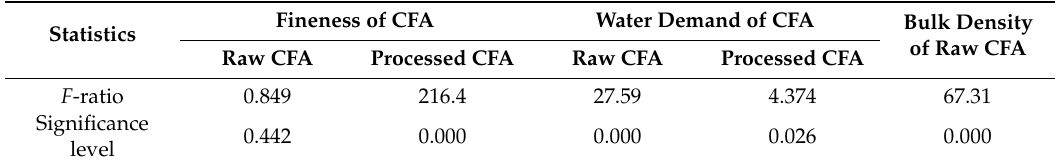
Table 3. ANOVA involving the influence of the source of CFA (B1, B2, T) on its properties. Fineness of Statistics